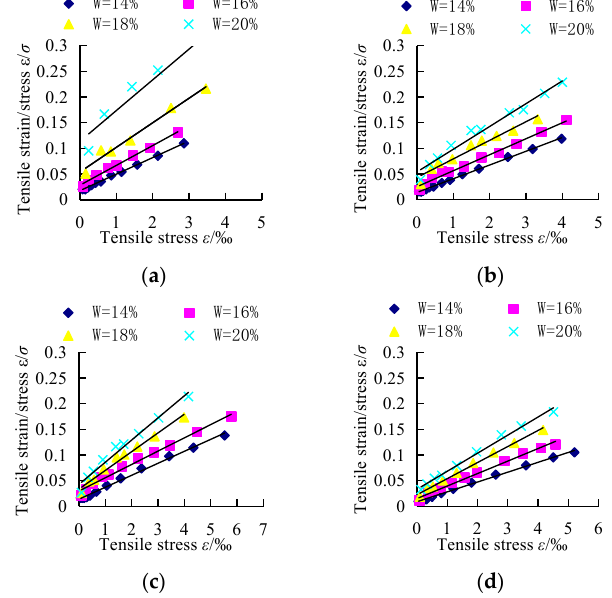
Figure 18. Transformed hyperbolic stress-strain curve: ( a ) ρ d = 1.28 g/cm 3 ; ( b ) ρ d = 1.37 g/cm 3 ; ( c ) ρ d = 1.46 g/cm 3 ; ( d ) ρ d = 1.53 g/cm 3